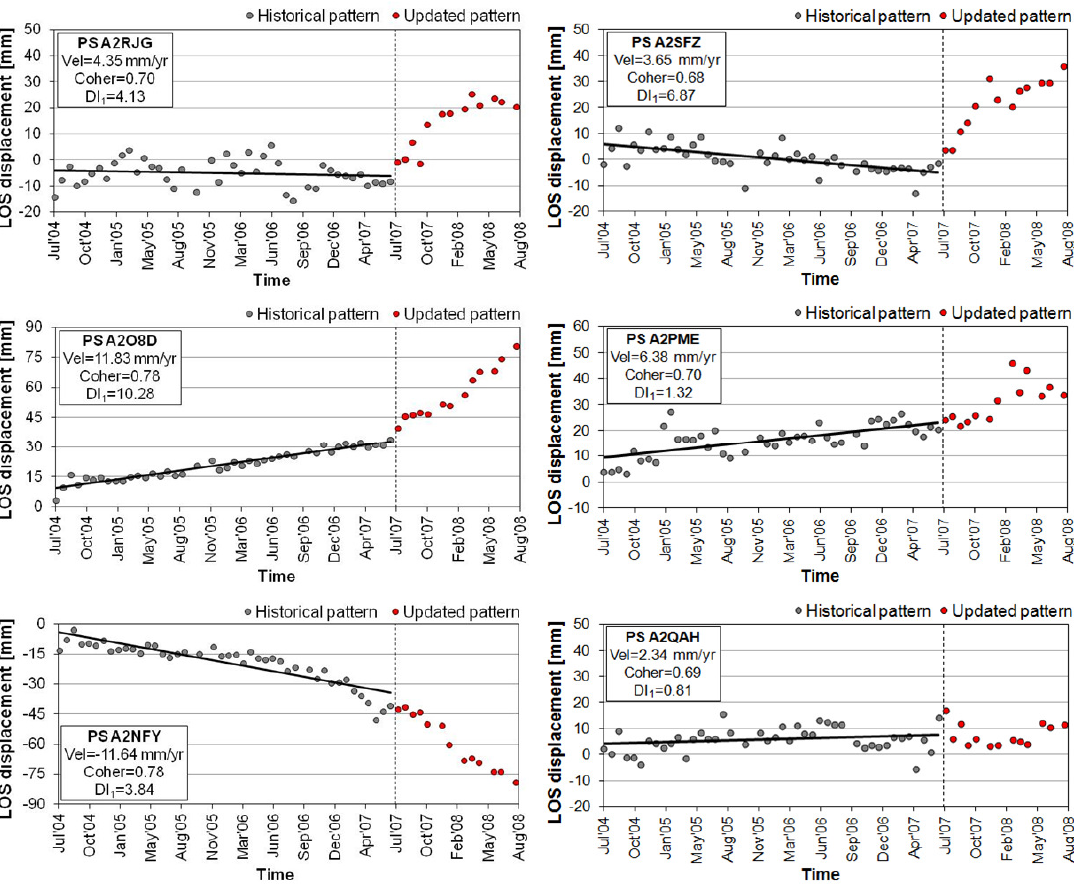
Fig. 6. St. Barbara test site: examples of PS time series showing high values of DI 1 . PS locations are shown in Fig. 5. The coefficient of determination R 2 for the H interval of the time series is: 0.019 (PS A2RJG); 0.398 (PS A2SFZ); 0.934 (PS A2O8D); 0.458 (PS A2PME); 0.783 (PS A2NFY); 0.054 (PS A2QAH).